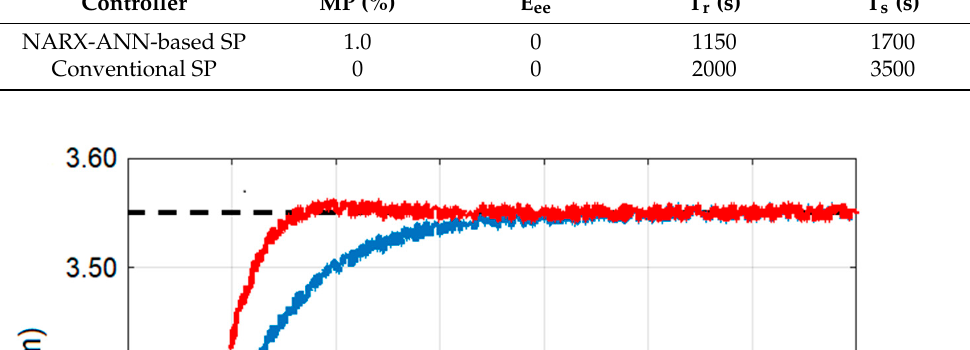
Figure 12. Experimental comparative output signals of the controllers designed. From Figure 11 and Table 1 it is observed that the control system with the NARX- ANN-based SP controller designed reaches the new reference water level practically with- out overshoot and with zero steady state error—like the conventional SP—but the rise time and the settling time are approximately the 50% of the times yielded by the conven- tional SP. After time 3500 s, the responses provided by both control systems have reached the new setpoint with zero steady state error and, therefore, their steady time responses are similar. We highlight that the same responses attained after 3500 s is consequence of the integral terms included in the structures of controller (17) and the PI controller (18), which is a common term in both control systems. However, the main difference is pro- duced in the transient, in which our proposal achieves the final value much faster than the conventional SP controller.